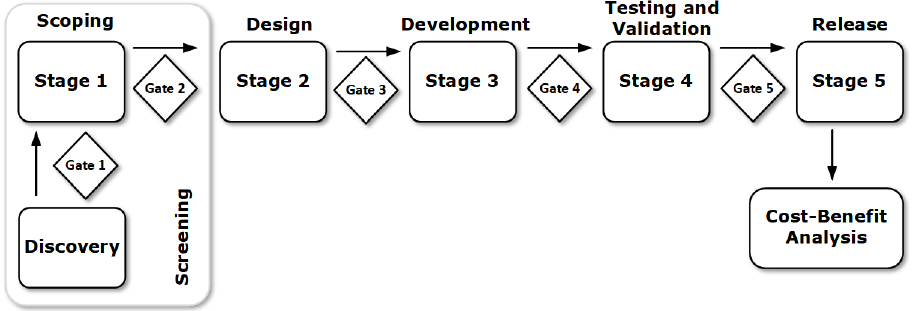
Figure 1. Overview of the generic Stage-Gate system. Source: [44].